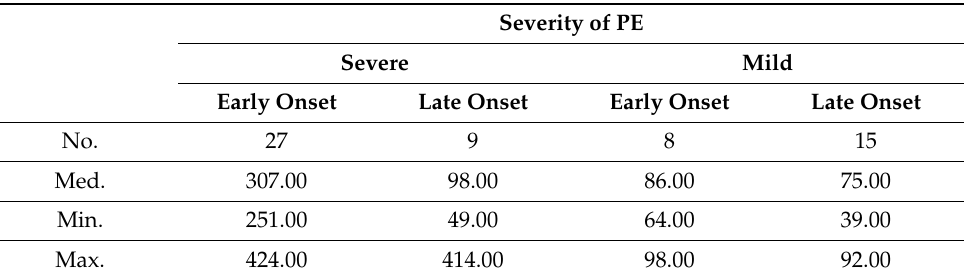
Figure 3. ROC curve of sFtl-1/PIGF ratio in mild versus severe PE. 3.8. The Value of the sFtl-1/PIGF Ratio According to Gestational Age at Onset and Severity of Preeclampsia